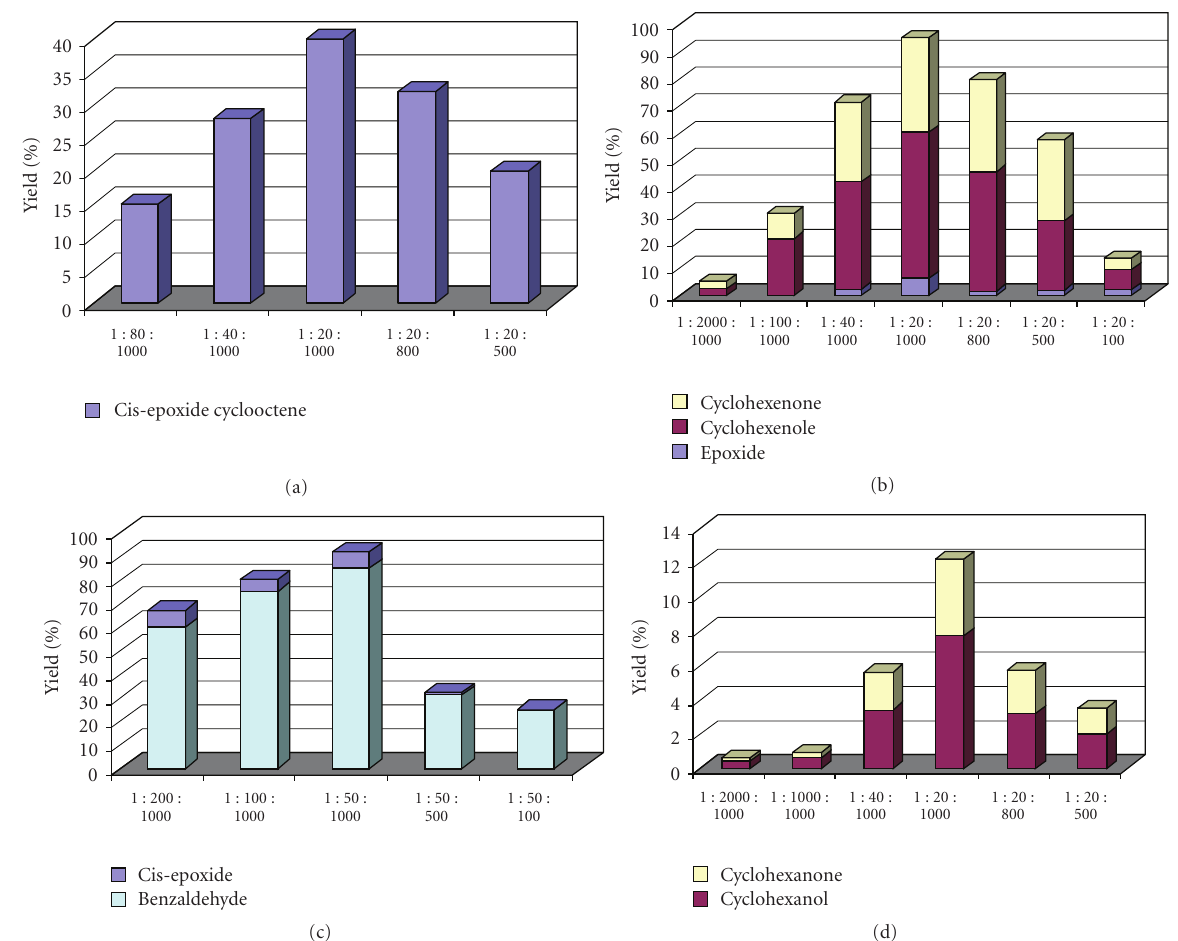
Figure 1: (a) Cis-cyclooctene oxidation is catalysed by LFe III Cl at varied Substrate-Oxidant molar ratio in CH 3 CN with H 2 O 2 . (b) Cyclohexene oxidation is catalysed by LFe III Cl at varied Substrate-Oxidant molar ratio in CH 3 CN with H 2 O 2 . (c) Styrene oxidation is catalysed by LFe III Cl at varied Substrate-Oxidant molar ratio in CH 3 CN with H 2 O 2 . (d) Cyclohexane oxidation is catalysed by LFe III Cl at varied Substrate-Oxidant molar ratio in CH 3 CN with H 2 O 2 . For all figures The given ratio is catalyst : oxidant: substrate.